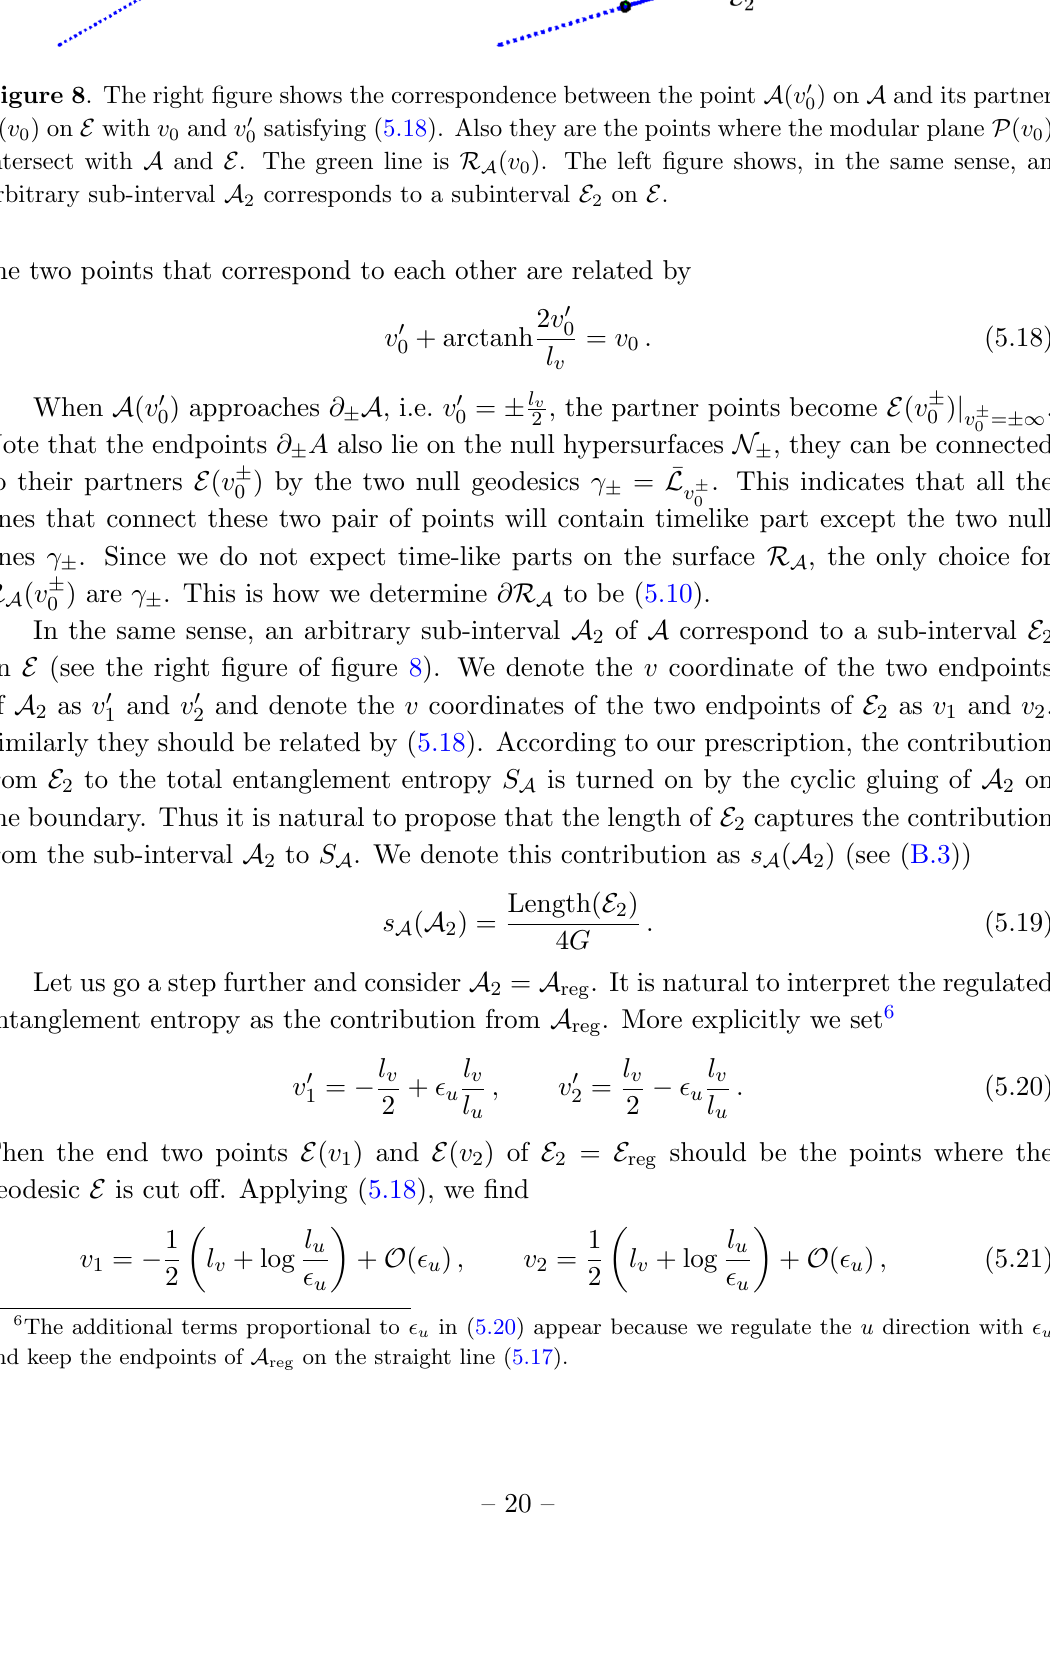
) on A and its partner 0